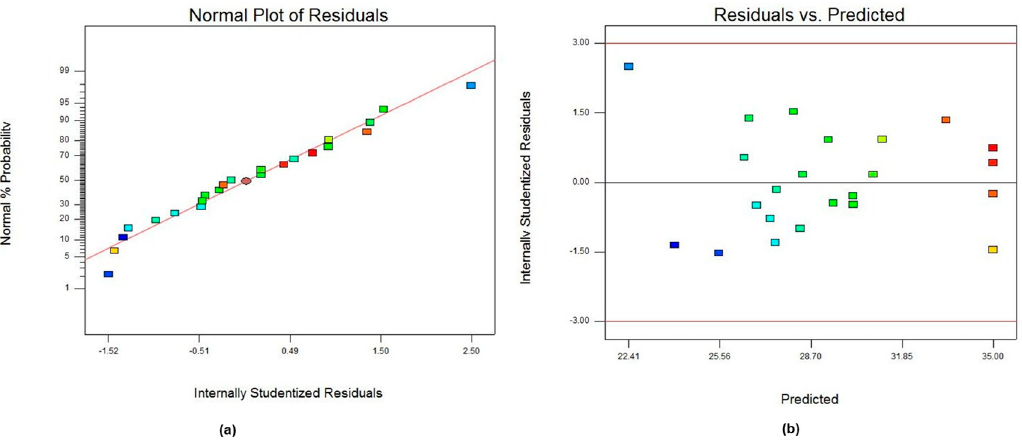
Figure 3. Plots of: ( a ) normal probability of residuals; and ( b ) residual vs. predicted value for CCD analysis.